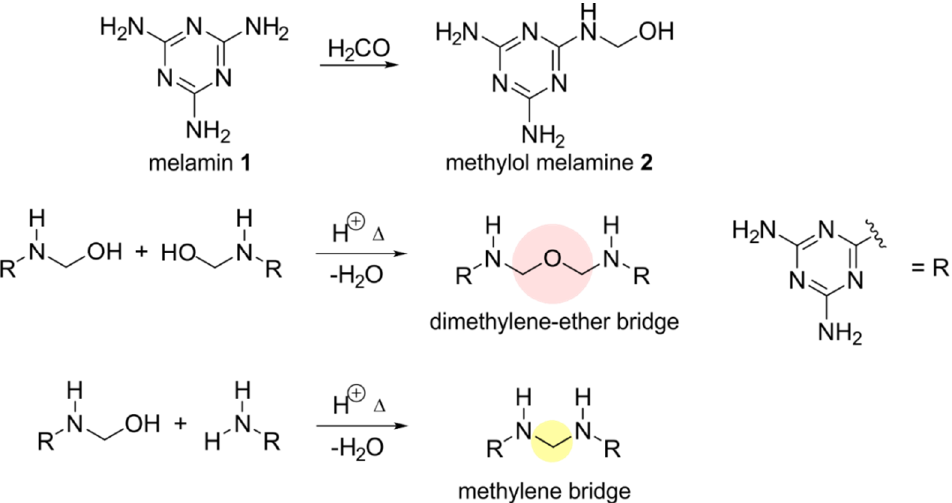
Figure 1. Schematic representation of the initial reactions of the synthesis of melamine resins from melamine and formaldehyde (simplified).